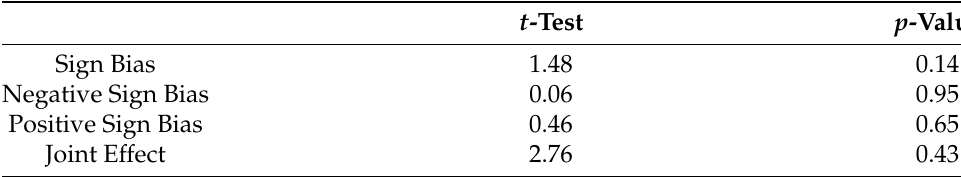
Table 6. t -test values of the sign bias test for standardized